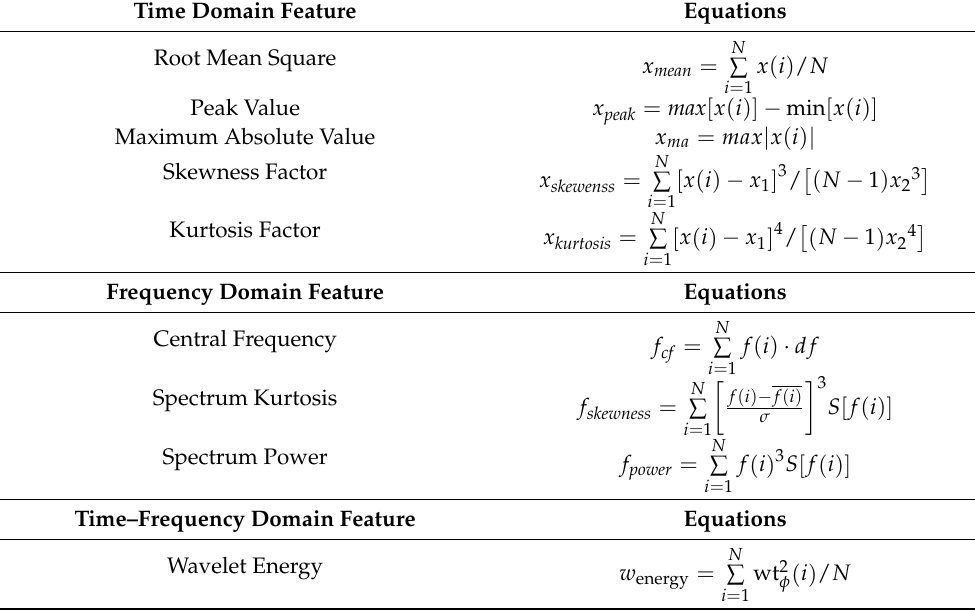
Table 8. Extracted tri-domain features.